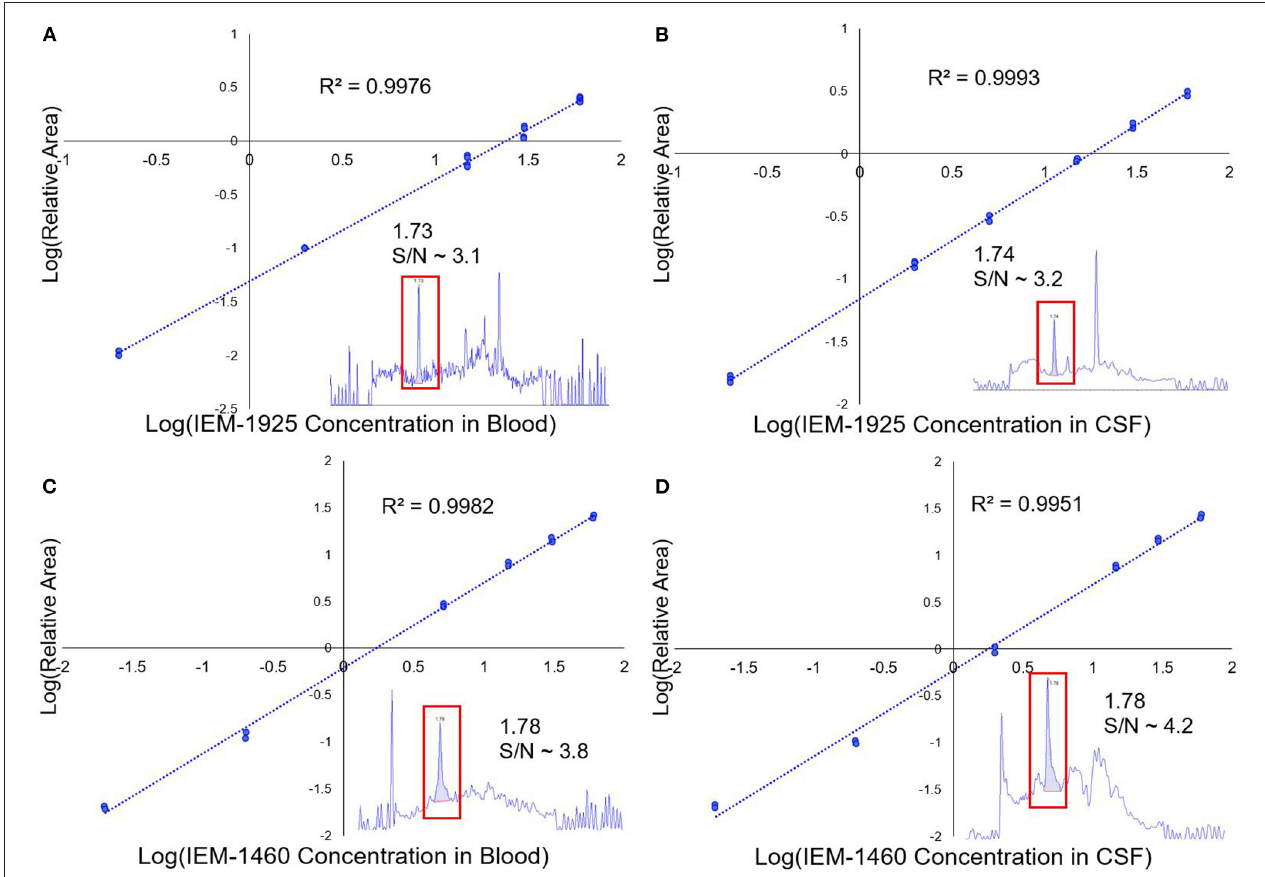
FIGURE 2 | LC/MS calibration curves for IEM-1925 and IEM-1460. (A) The LC/MS calibration curve showing the relative area of IEM-1925 to internal standard (verapamil) in blood is plotted against IEM-1925 concentration. Replicates for each concentration were obtained with duplicate injections. The 1ng/mL standard in blood chromatogram with S/N ∼ 3.1 is shown in the inset that eluted at 1.73min. (B) Similarly, LC/MS calibration curve showing IEM-1925 in CSF matrix is plotted against the internal standard. The 1ng/mL standard in CSF with S/N ∼ 3.2 is shown in the inset eluting at 1.74min. (C) IEM-1460 calibration curve in blood with inset showing 1ng/mL IEM-1460 in blood with S/N ∼ 3.8 eluting at 1.78min. (D) IEM-1460 calibration curve in CSF with inset showing 1ng/mL IEM-1460 in CSF with S/N ∼ 4.2 eluting at